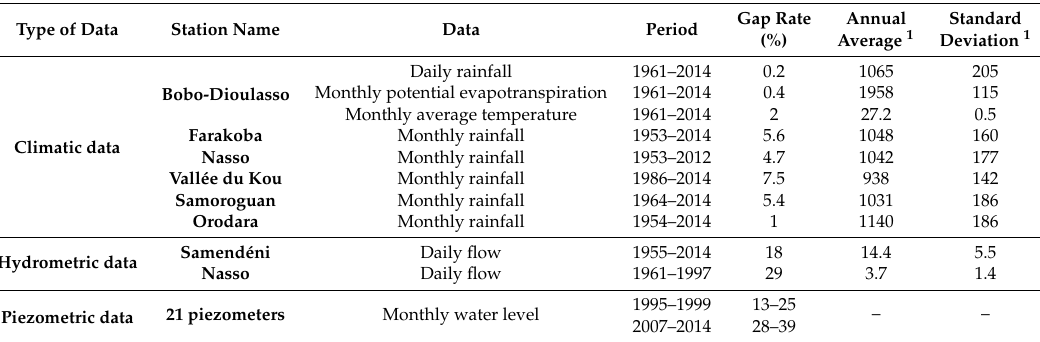
Table 1. Available data used for the present